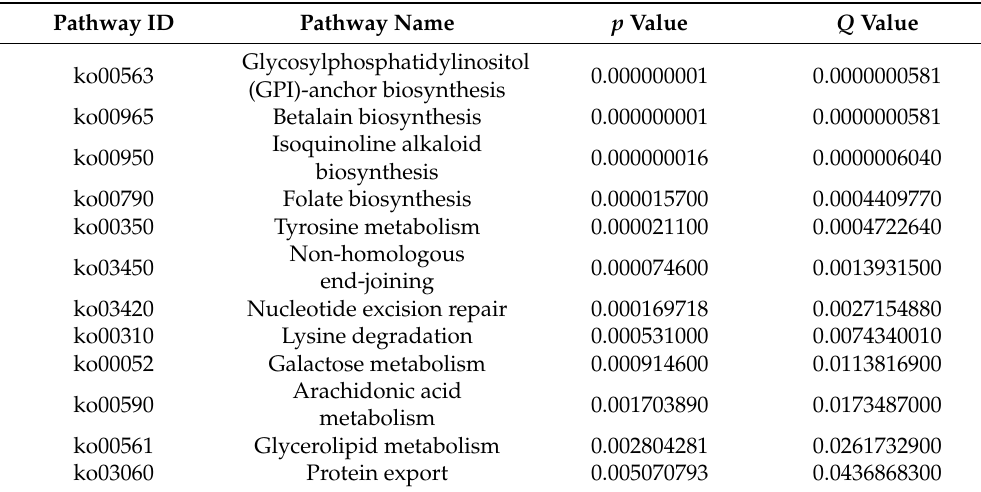
Table 2. KEGG pathway enrichment results of DEGs in F A W A versus F E W E .